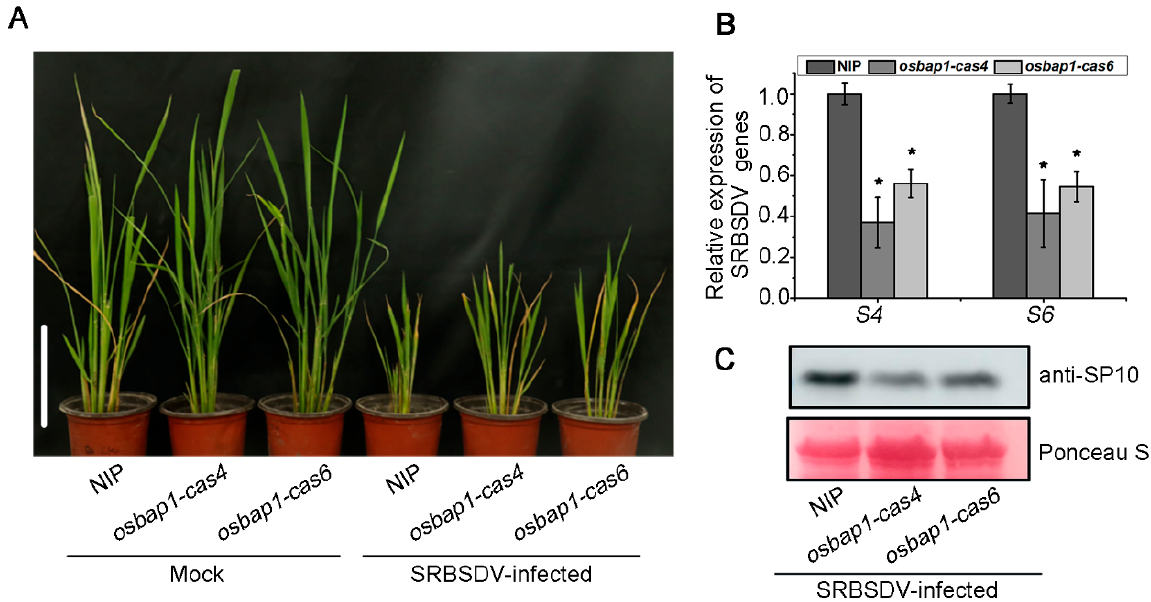
Figure 2. OsBAP1 negatively regulates rice resistance to SRBSDV: ( A ) The symptoms of SRBSDV in WT (NIP) and OsBAP1 mutant ( osbap1-cas4 and osbap1-cas6 ) plants. The phenotypes were photographed at 30 dpi. White bar represents 10 cm. ( B ) The relative expression levels of SRBSDV S4 and S6 genes in SRBSDV-infected NIP and osbap1-cas plants as detected by RT-qPCR at 30 dpi. UBQ5 was used as the internal reference gene to normalize the relative expression. Values are the means ± SD from 3 biologically independent samples. * at the top of columns indicates significant differences ( p -value ≤ 0.05) based on Fisher’s least significant difference tests. ( C ) The accumulation of SRBSDV SP10 protein in SRBSDV-infected plants determined by Western blotting at 30 dpi. Total proteins were stained with Ponceau stain to confirm equal loading.